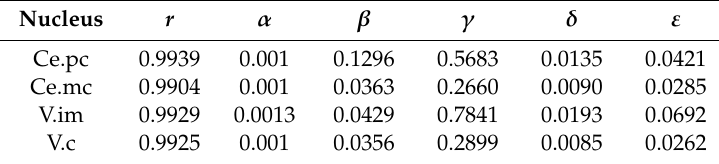
Figure A3. Representation of both parts of double exponential functions for Ce.pc (red), Ce.mc (blue), V.im (green), and V.c (yellow). Continuous lines represent the first part of equations ( β e − γ x ) and discontinuous ones the second parts ( δ e − ε x ) of Equation (2). Table A1. Parameters for the double negative exponentials functions fitted for pdf.